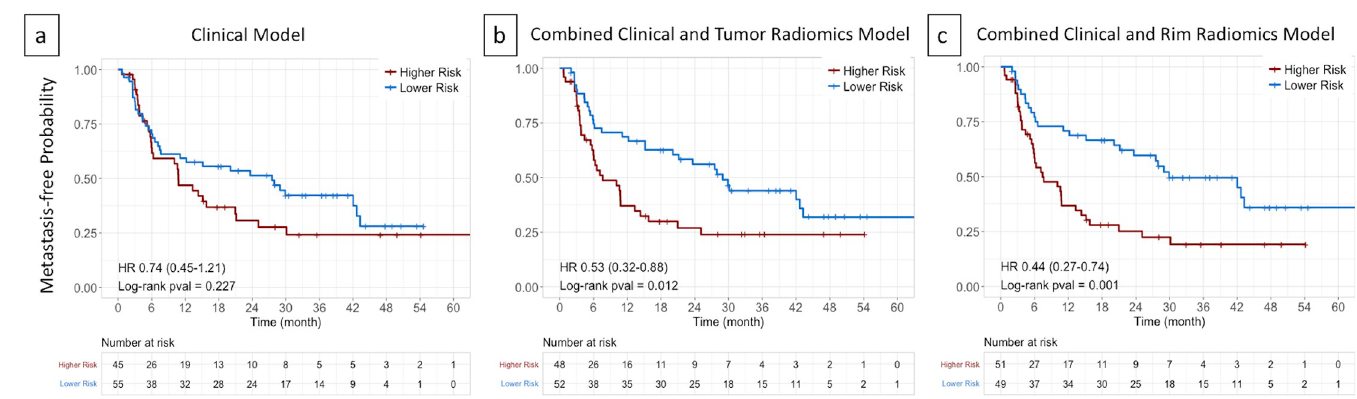
Fig 4. Comparison of Kaplan-Meier curves for DM : a) clinical model, b) the combined clinical and tumor radiomics model, and c) the combined clinical and tumor rim radiomics model for metastasis-free probability in validation dataset (n = 100). In a, the stratified patient groups did not show statistical significance (p- value < 0.227). In b, the incorporation of the tumor radiomics signature improved patient stratification (p-value < 0.012). In c, combining clinical and rim radiomics signature was shown to most significantly stratify patients (p-value <